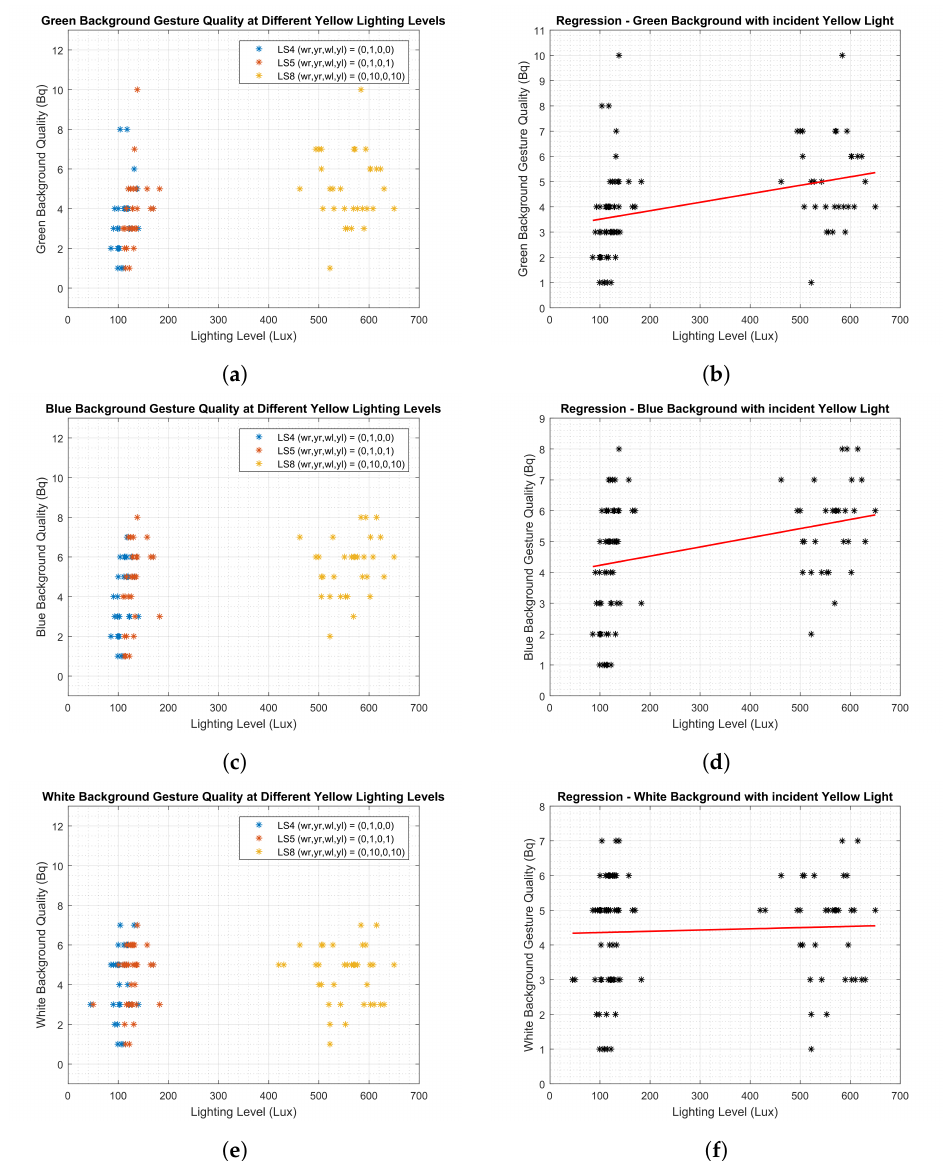
Figure 16. VLL yellow incident LED light on green, blue, and white backgrounds. ( a ) VLL green background, ( b ) VLL green background regression, ( c ) VLL blue background, ( d ) VLL blue background regression, ( e ) VLL white background, ( f ) VLL white background